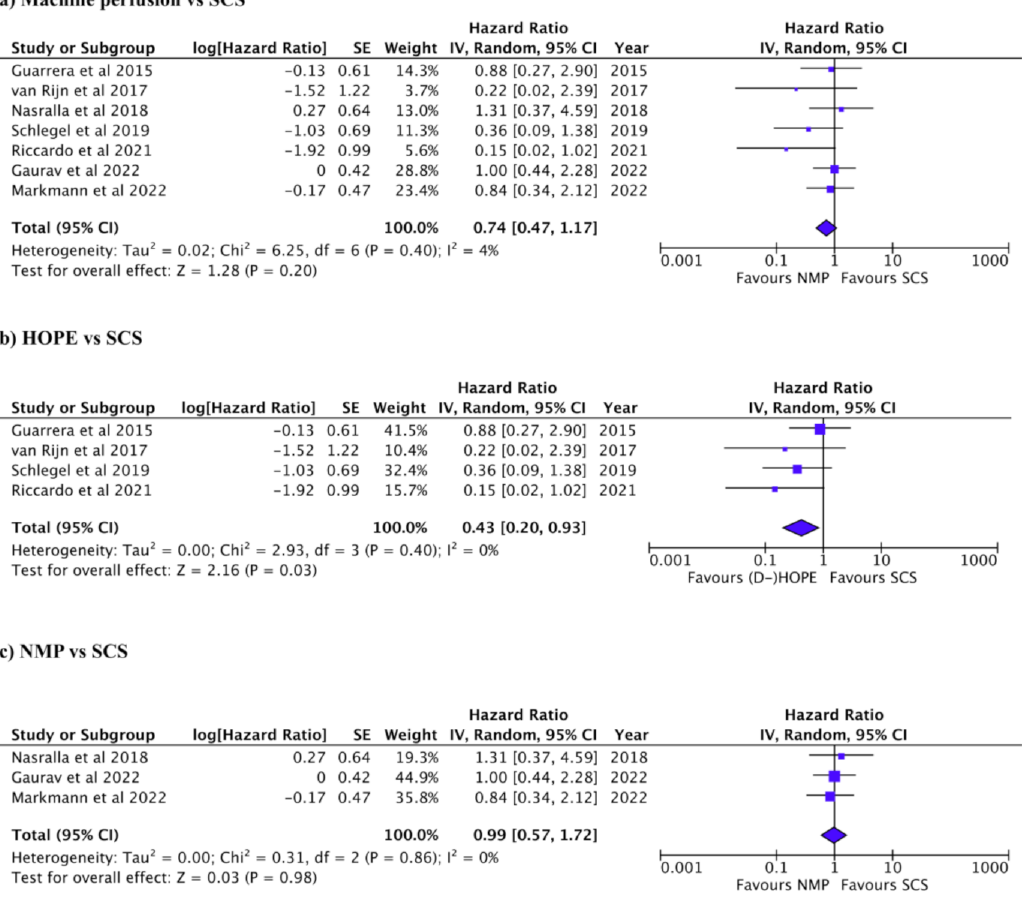
Figure 6. Forest plots for patient survival. ( a ) Machine perfusion (hypothermic or normothermic) vs. SCS ( P = 0.20). ( b ) HOPE vs. SCS ( P = 0.03). ( c ) NMP vs. SCS ( P =